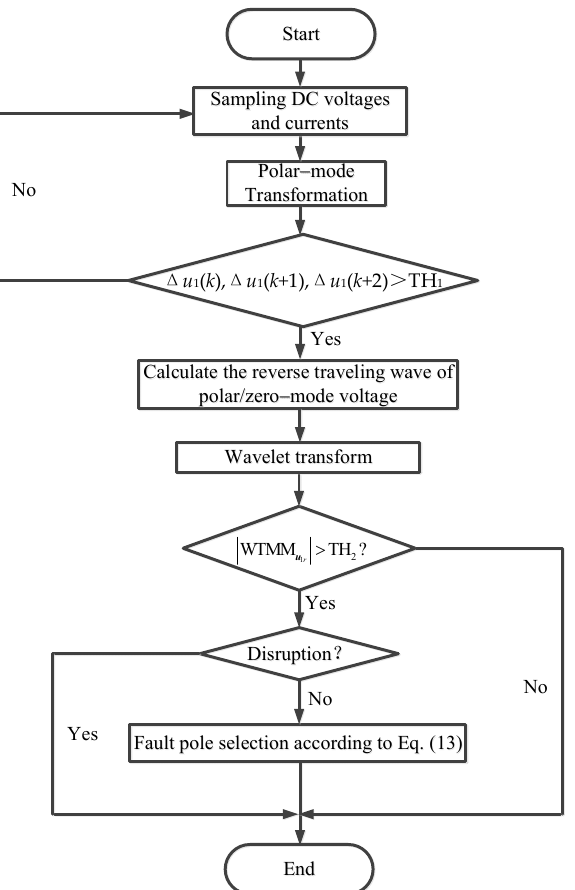
Figure 5. Flow chart of single ‐ ended traveling wave protection for HVDC grid.